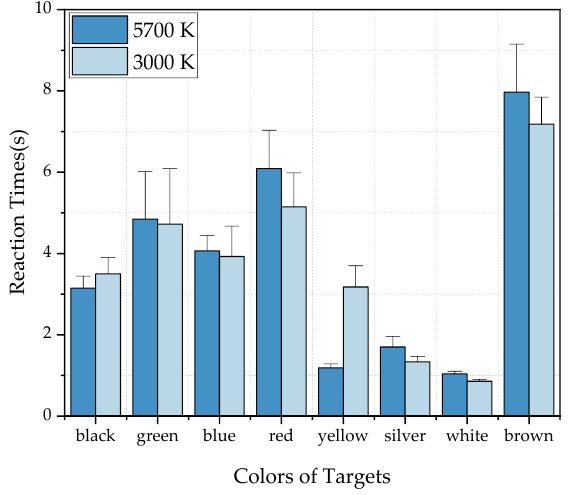
Figure 16. The mean reaction time of di ff erent colors under di ff erent lighting conditions when HP-CCT = 5700 K and 3000 K. The error bars indicate the standard deviation of di ff erent lighting conditions.